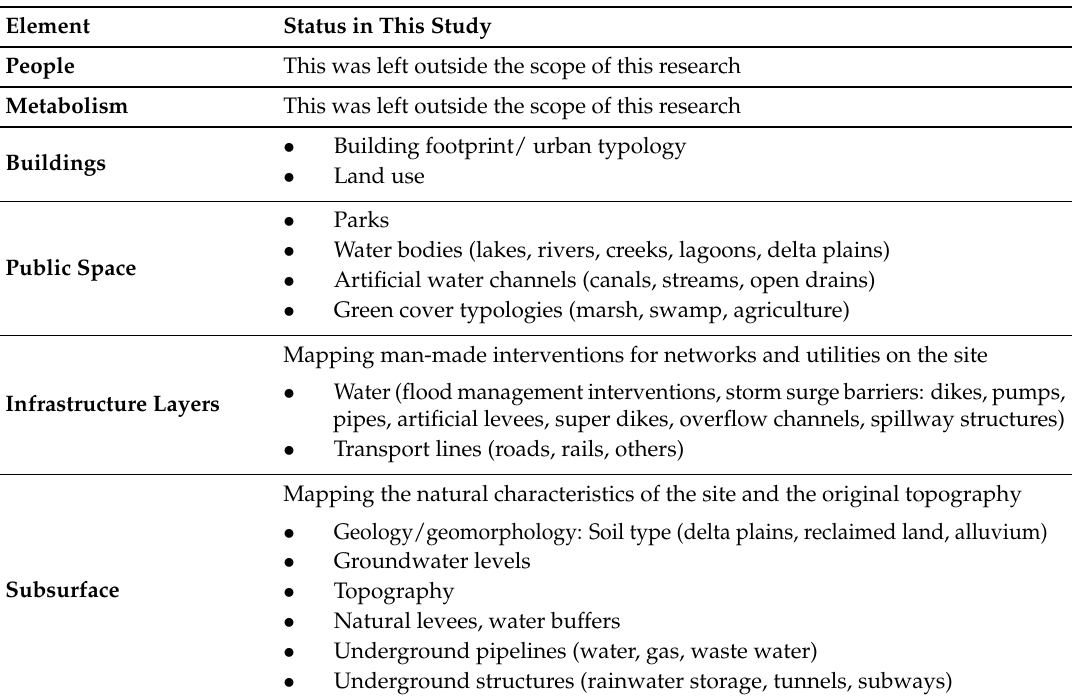
Table 2. Research scope following the Dutch layer method [25] and the system exploration environment and subsurface (SEES) method